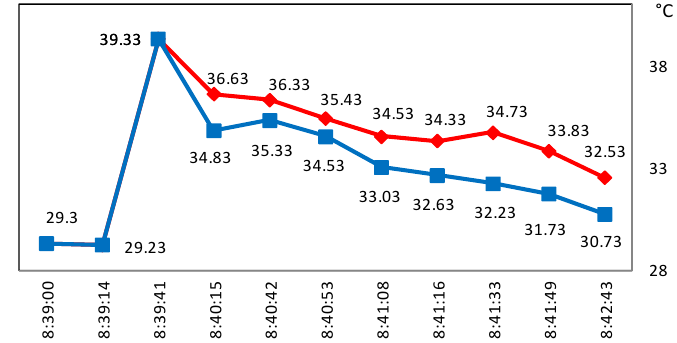
Figure 10. The temperature values in the junction box and its immediate area.